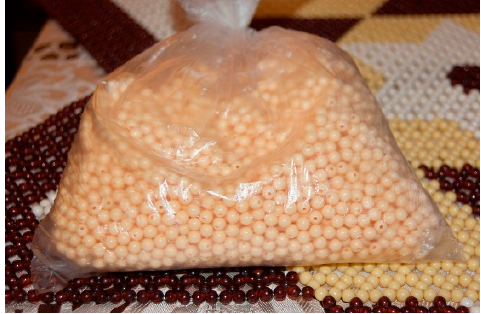
Figure 5. Plastic bag with beads.